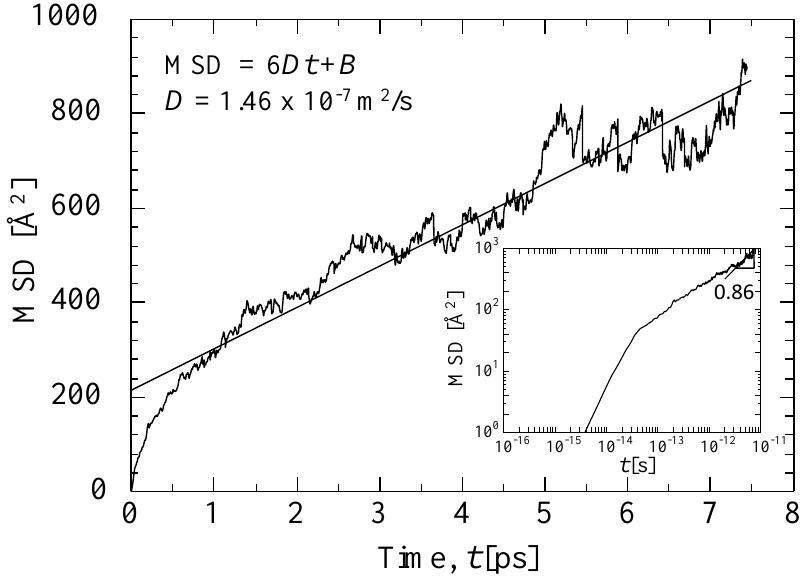
Figure 9. Example of the mean squared displacement (MSD) of helium at 800 K for a virtual silica membrane model ( k = 100, 2.1 g / mL).